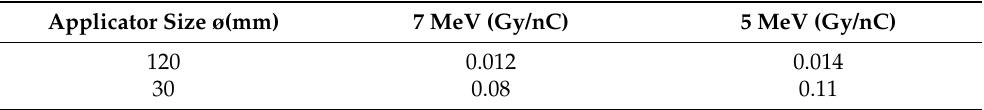
Table 4. Summary of film and Faraday cup measurements. Beam size: A-d30 ( φ = 30 mm) and A-d120 ( φ = 120 mm); the dose per pulse is calculated on film with an uncertainty of 5%. The charge measurements were performed using a Faraday cup. The table shows the dose per pulse in Gy/nC, obtained with different applicators for a pulse duration of 4 µ